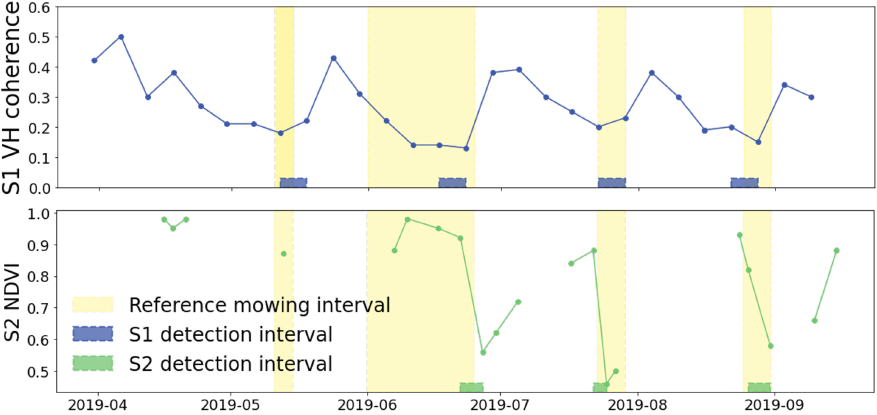
Figure 6. Illustration of the mowing detection algorithms of the Sen4CAP toolbox, based on Sentinel-1 VH coherence and Sentinel-2 NDVI time series extracted on a permanent grassland